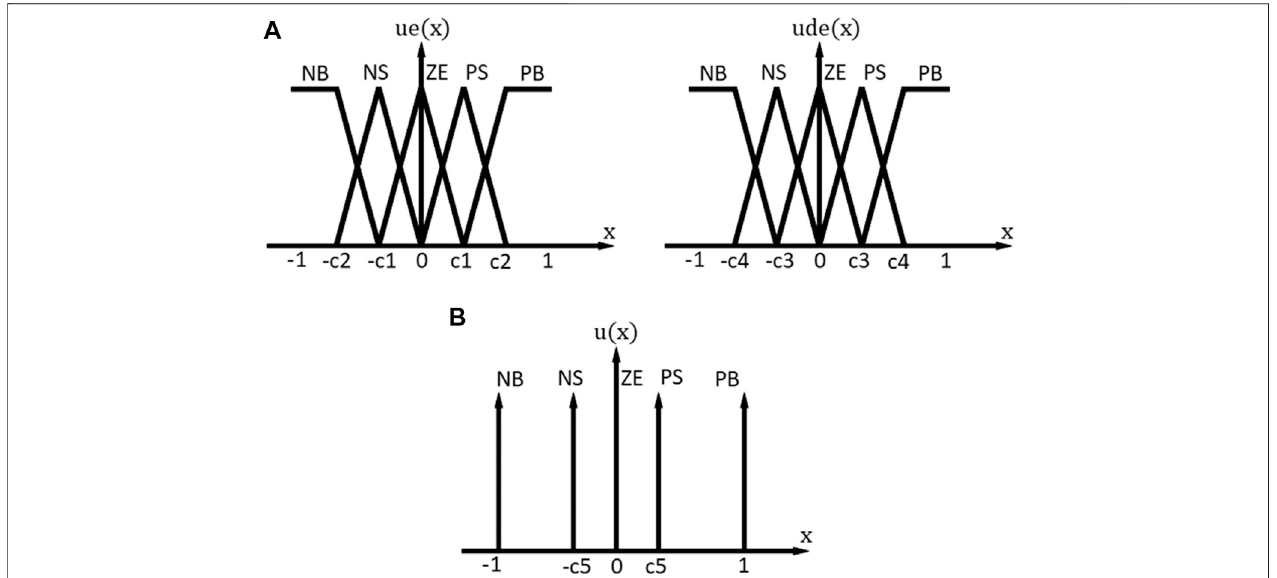
FIGURE 5 | Fuzzy membership functions (A) input membership functions (B) output membership functions.